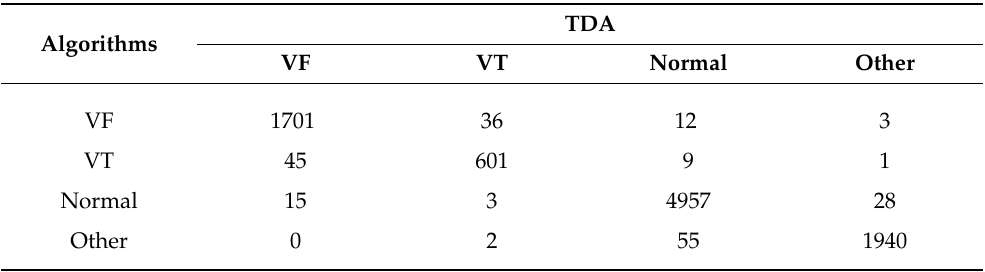
Table 5. Confusion matrix for classification of VF , VT , Others , and Normal classes using the TDA topological method.